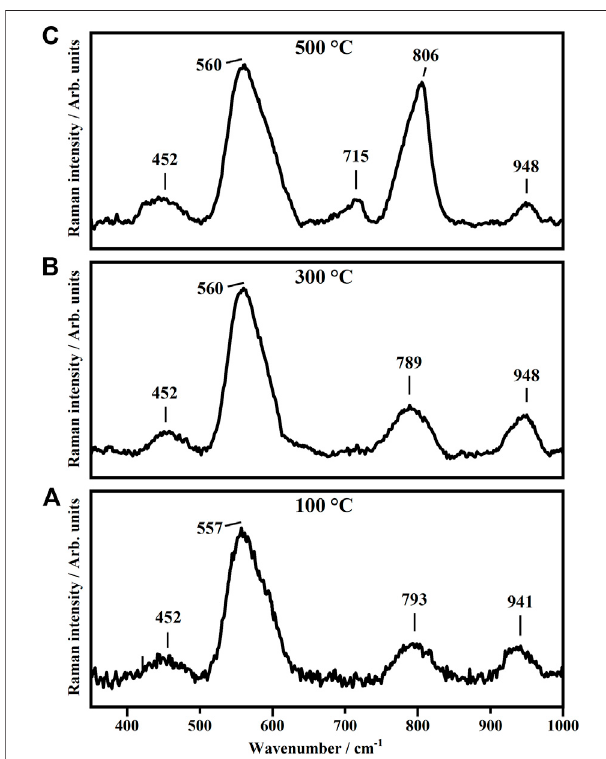
FIGURE 1 | Representative Raman Spectra collected on WO 3 thin fi lms annealed, for 1 h, at 100 ° C (A) , 300 ° C (B) and 500 ° C (C) .